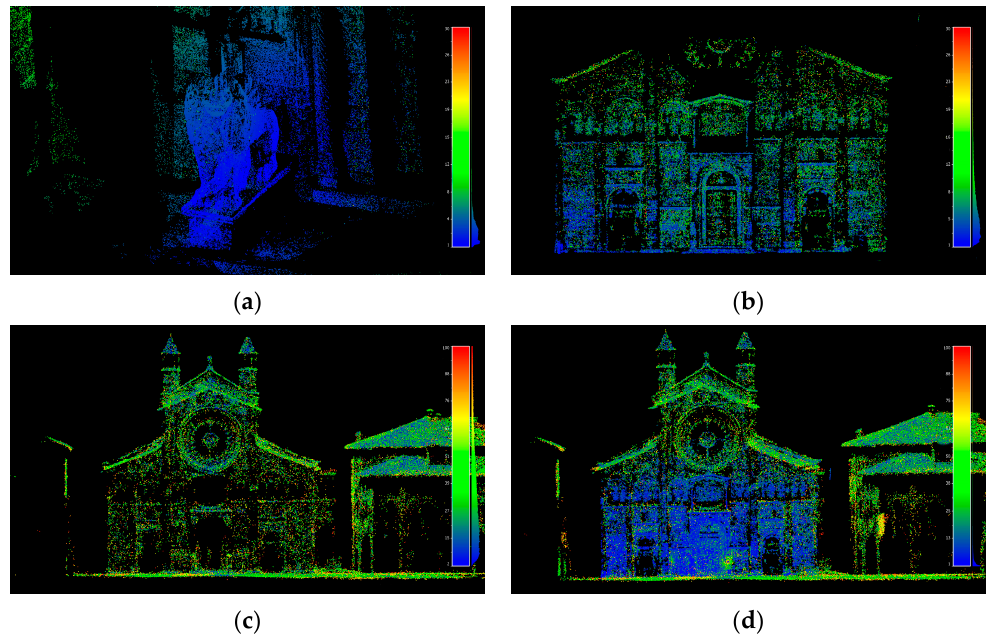
Figure 3. Visualization of the a-posteriori standard deviation ( σ ) precisions computed on the original (not filtered) sparse point clouds: terrestrial-convergent ( a ), terrestrial-parallel ( b ), UAV ( c ) and terrestrial and UAV combined ( d ). σ values in ( a , b ) are visualized in the range [1–30 mm], for ( c , d ) in the range [1–100 mm].